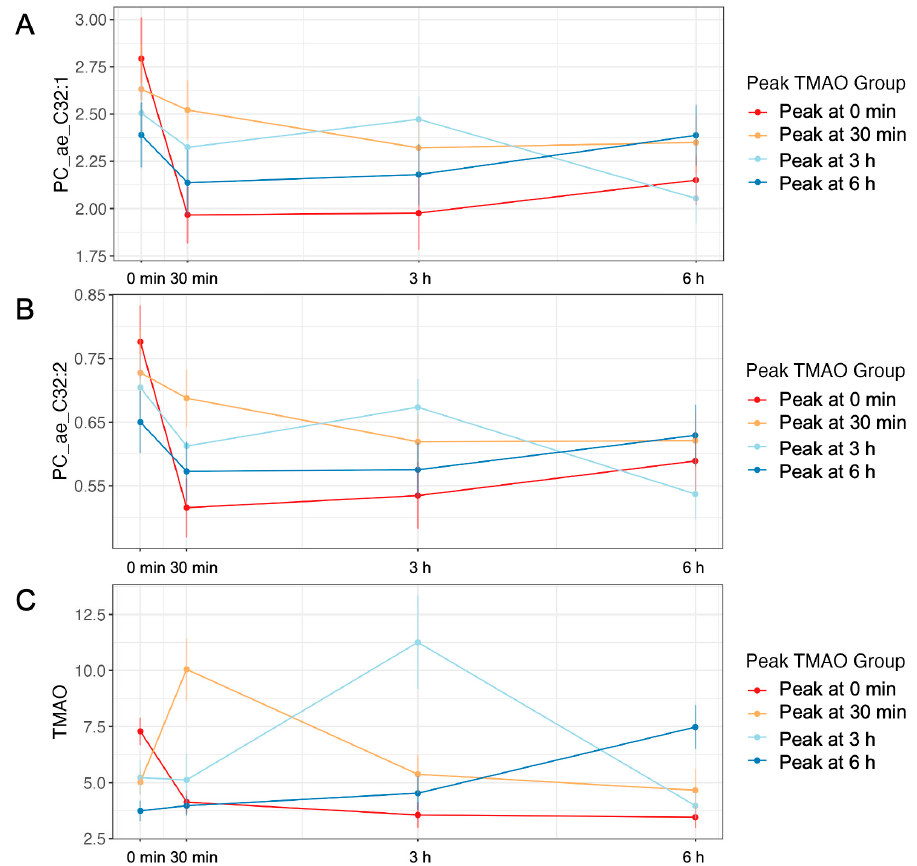
Figure 5. Postprandial responses of metabolites by peak TMAO-response group. Phosphatidylcholine with acyl-alkyl residue sum C32:2 (PC_ae_32:2, A ) and phosphatidylcholine with acyl-alkyl residue sum C32:1 (PC_ae_C32:1, B ) were positively correlated with TMAO (r = 0.295, Padj = 0.004; r = 0.250, Padj = 0.013) and showed similar appearance patterns to TMAO ( C ).